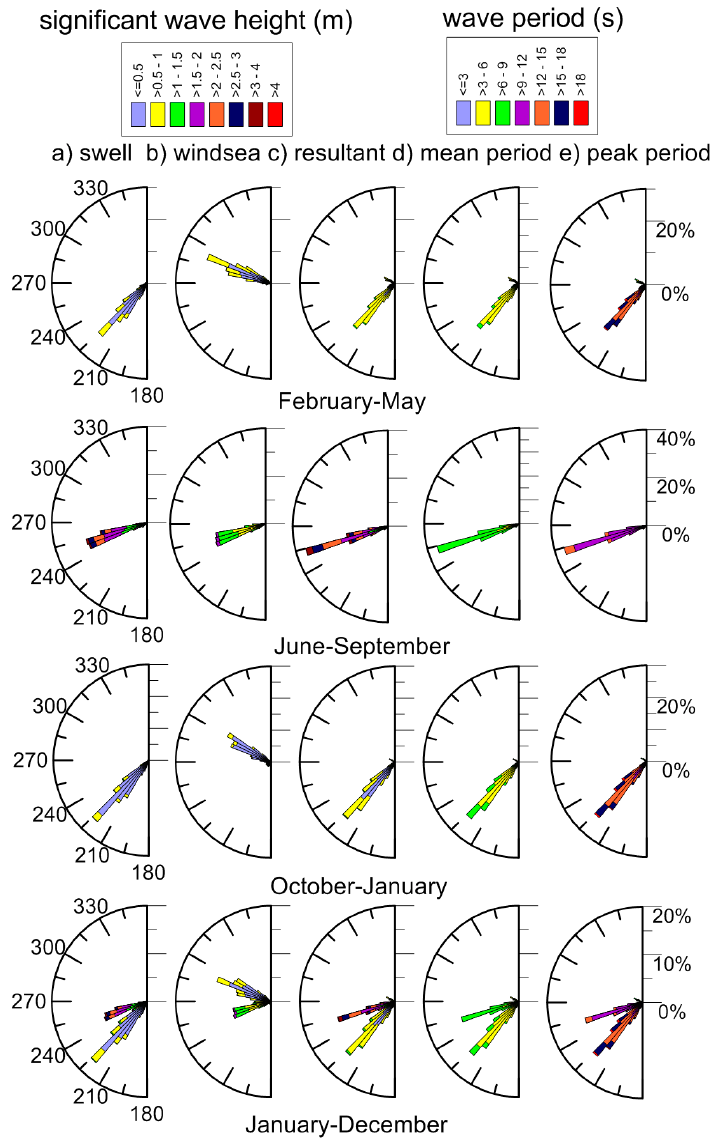
Figure 3. Wave rose diagram for significant wave height of ( a ) swell, ( b ) wind ‐ sea and ( c ) resultant. The right panel is for ( d ) mean wave period and ( e ) peak wave period in different seasons from 1 September 2014 to 31 August 2018 at 15 m water depth.